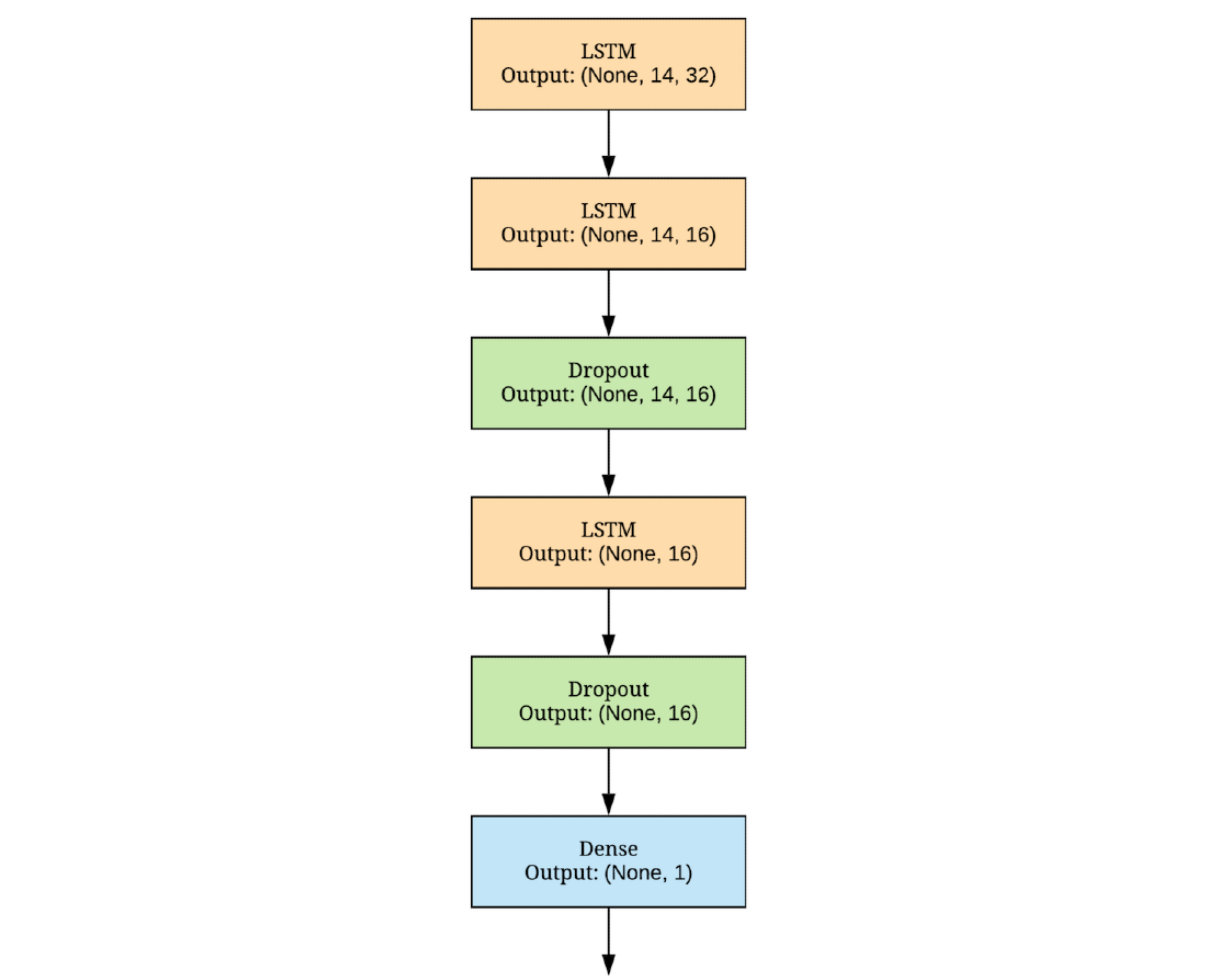
Figure 1. The proposed model architecture. LSTM: long short-term